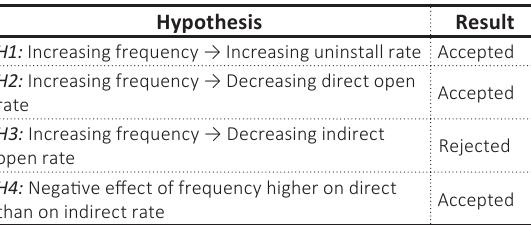
Table 7. Summary of experiment results